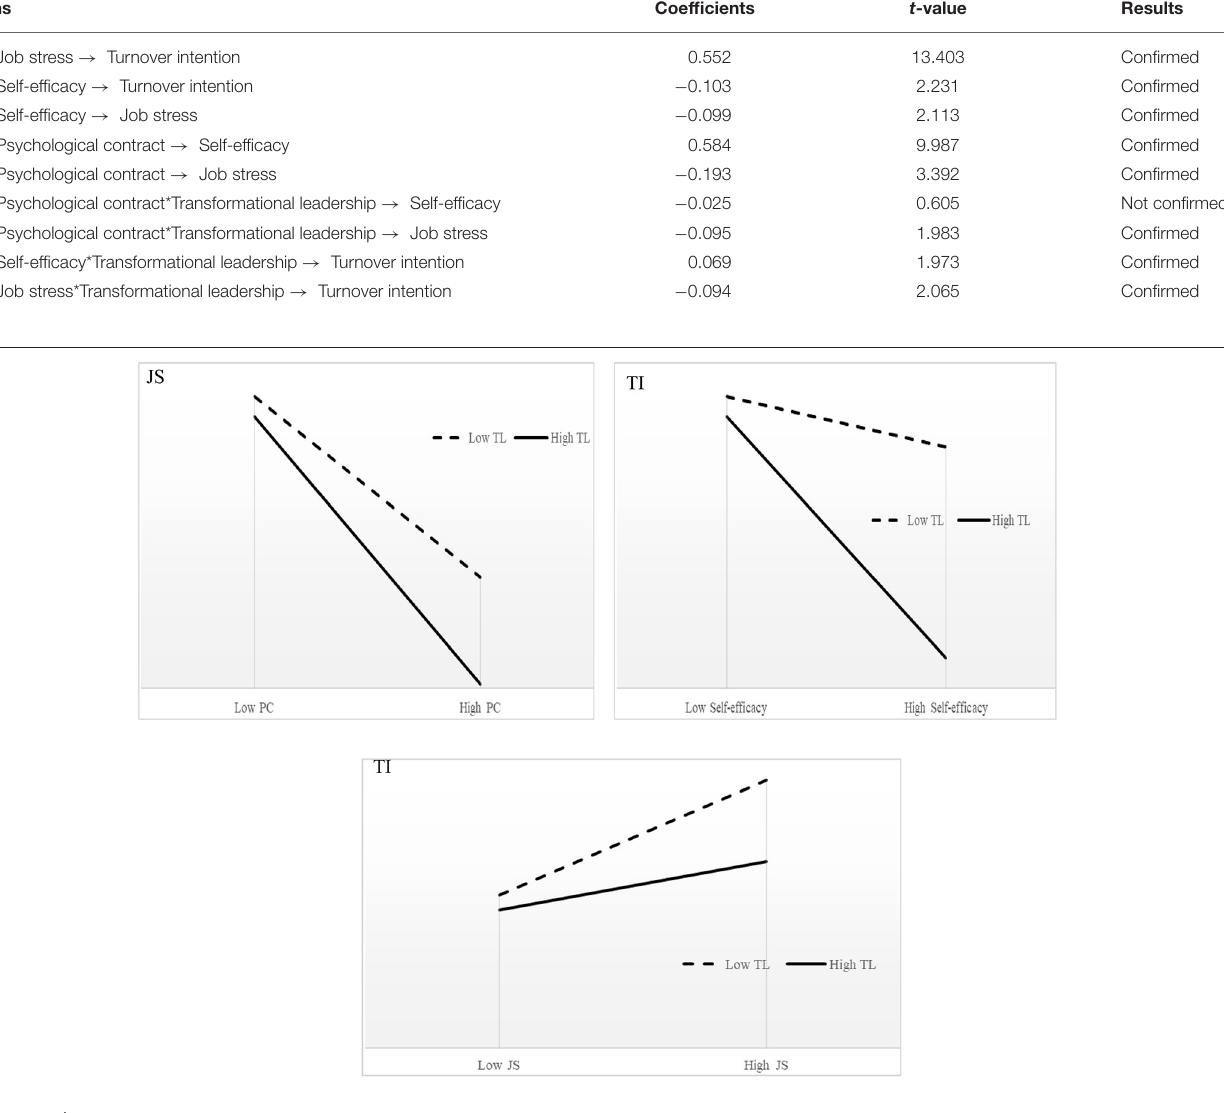
FIGURE 3 | Interaction effects. PC, psychological contract; TL, transformational leadership; TI, turnover intention; JS, job